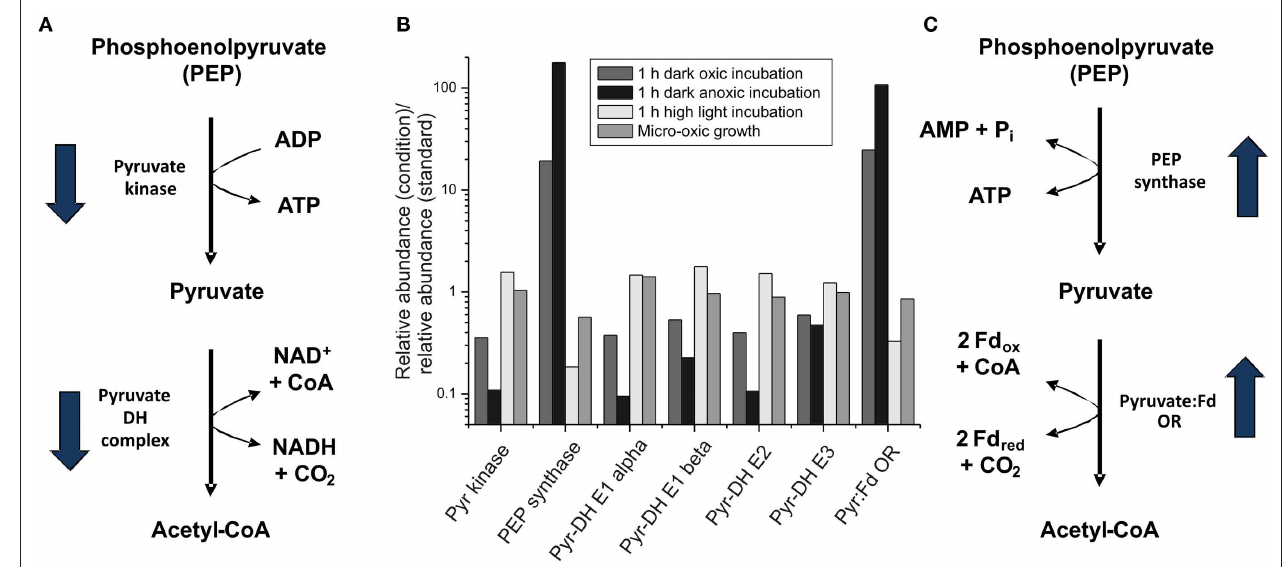
Figure 6 | Changes in the transcript levels for genes coding for proteins involved in pyruvate metabolism. Relative transcript levels for genes encoding proteins/enzymes involved in pyruvate metabolism [pyruvate (Pyr) kinase ( pyk ), phosphoenolpyruvate (PEP) synthase ( ppsA ), pyruvate dehydrogenase (Pyr-DH) complex (E1 alpha, E1 beta, E2 and E3 proteins; encoded by pdhA, pdhB , SYNPCC7002_A0110, ipdA ), and pyruvate:ferredoxin oxidoreductase (Pyr:Fd OR; nifJ )] are shown. The proposed reaction pathways from PEP to acetyl-CoA with